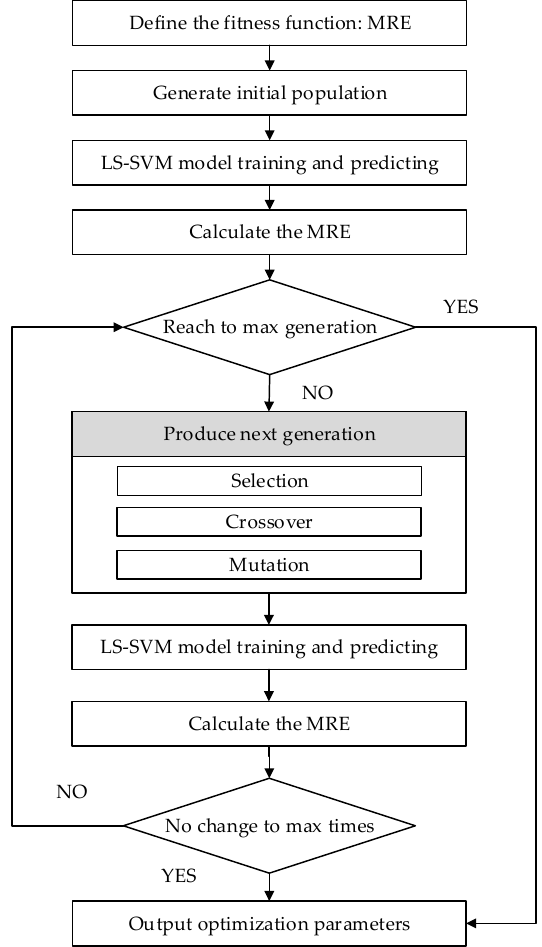
Figure 8. The flowchart of GA optimization for LS-SVM model parameters. MRE = mean relative error.